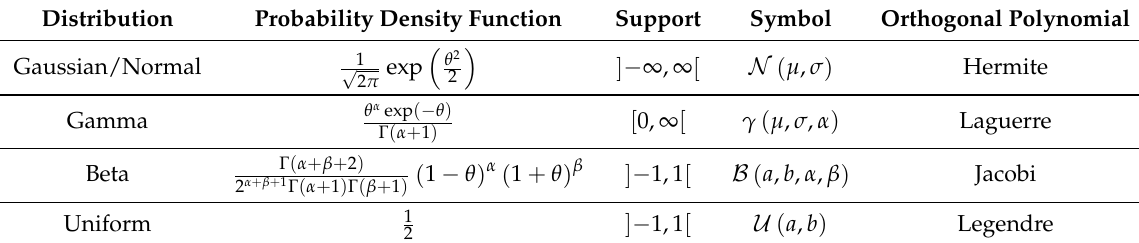
Table 1. Continuous density function-orthogonal polynomial connection for standard generalized polynomial chaos (after [1]) for a scalar parameter θ